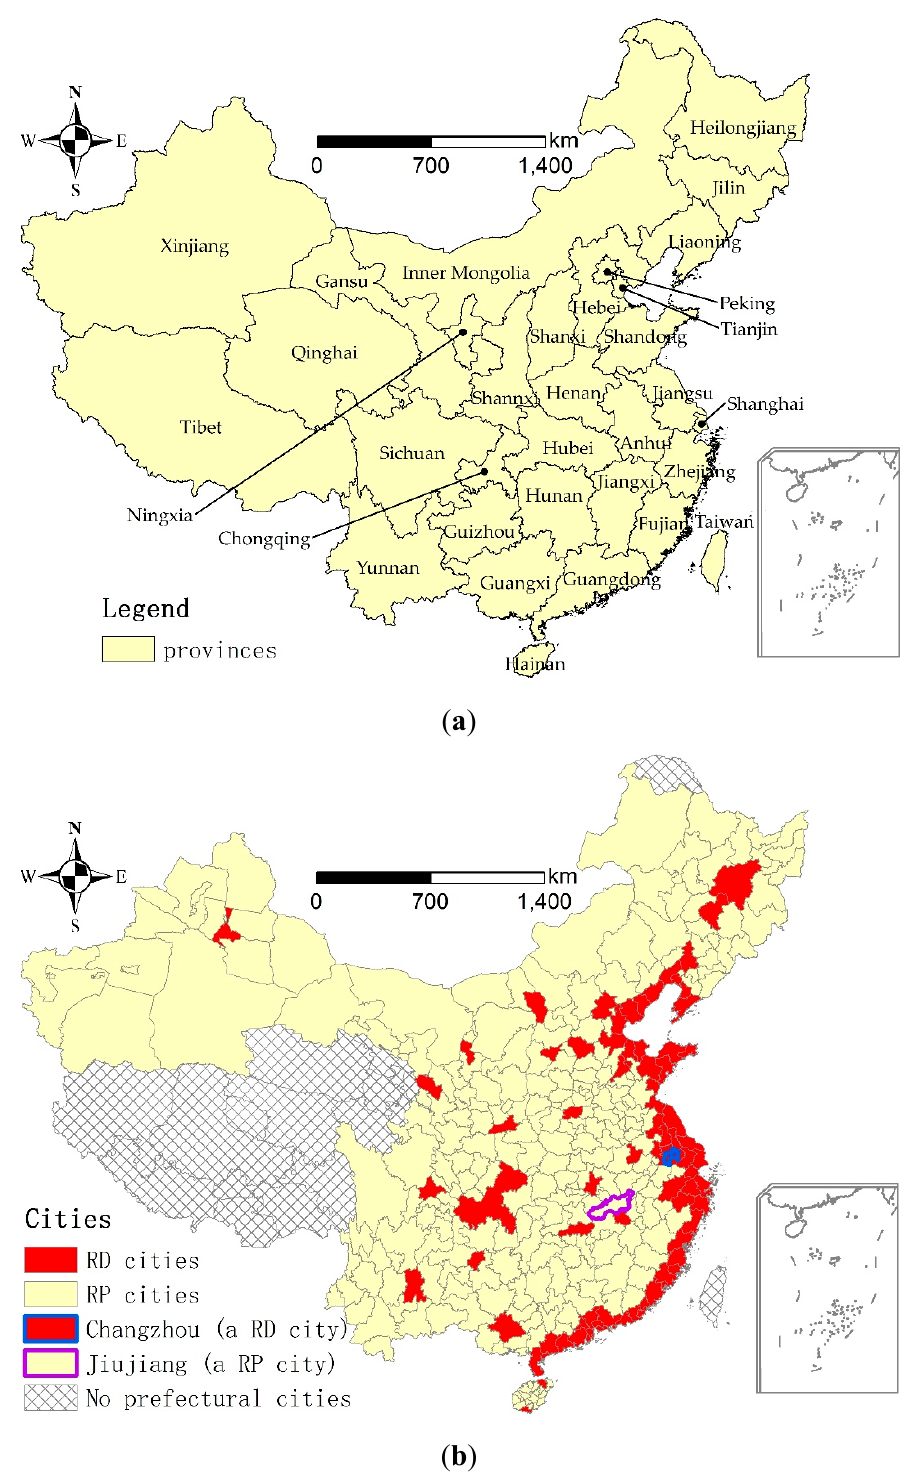
Figure 2. Provinces and the prefectural cities in China. ( a ) Provinces in China; ( b ) The prefectural cities in China.